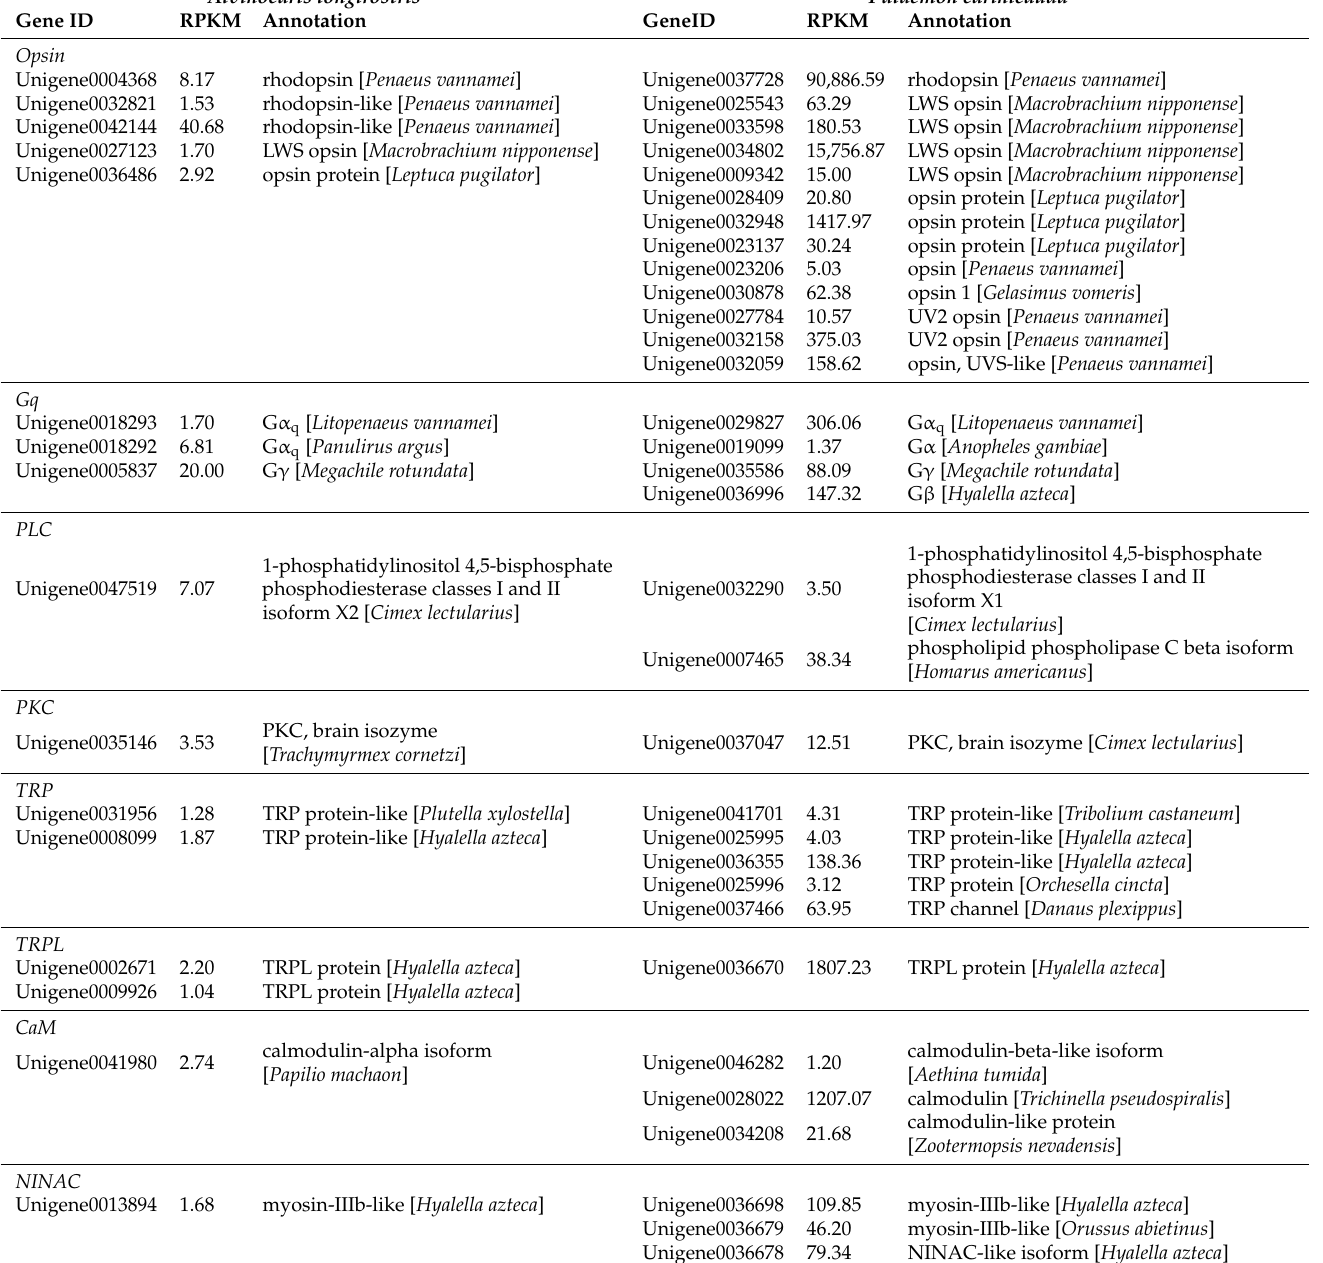
Table 2. Genes involved in the Gq-mediated phototransduction cascade from Alvinocaris longirostris and Palaemon carinicauda . They include opsin, G-protein, G-protein subunit alpha (G α ), beta (G β ) and gamma (G γ ), Gq subclass of the G-protein alpha (G α q) subunits, phospholipase C (PLC), protein kinase C (PKC), transient receptor potential (TRP) channels, transient receptor potential-like (TRPL) channels, calmodulin (CaM), neither inactivation nor afterpotential protein C (NINAC), arrestin, diacylglycerol lipase (DAGL), actin and INAD PDZ domains. RPKM (reads per kb per million reads) shows the gene expression level revealed by